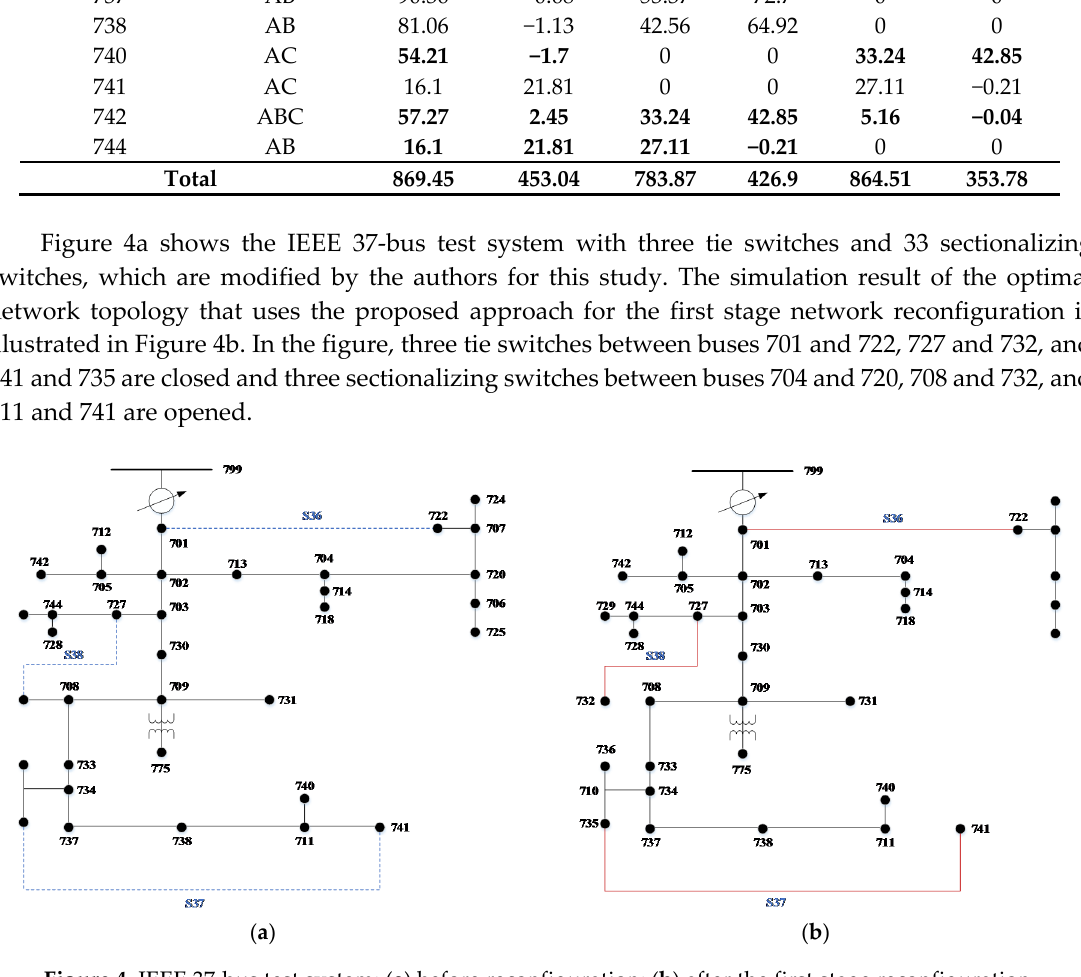
Figure 4. IEEE 37-bus test system: ( a ) before reconfiguration; ( b ) after the first stage